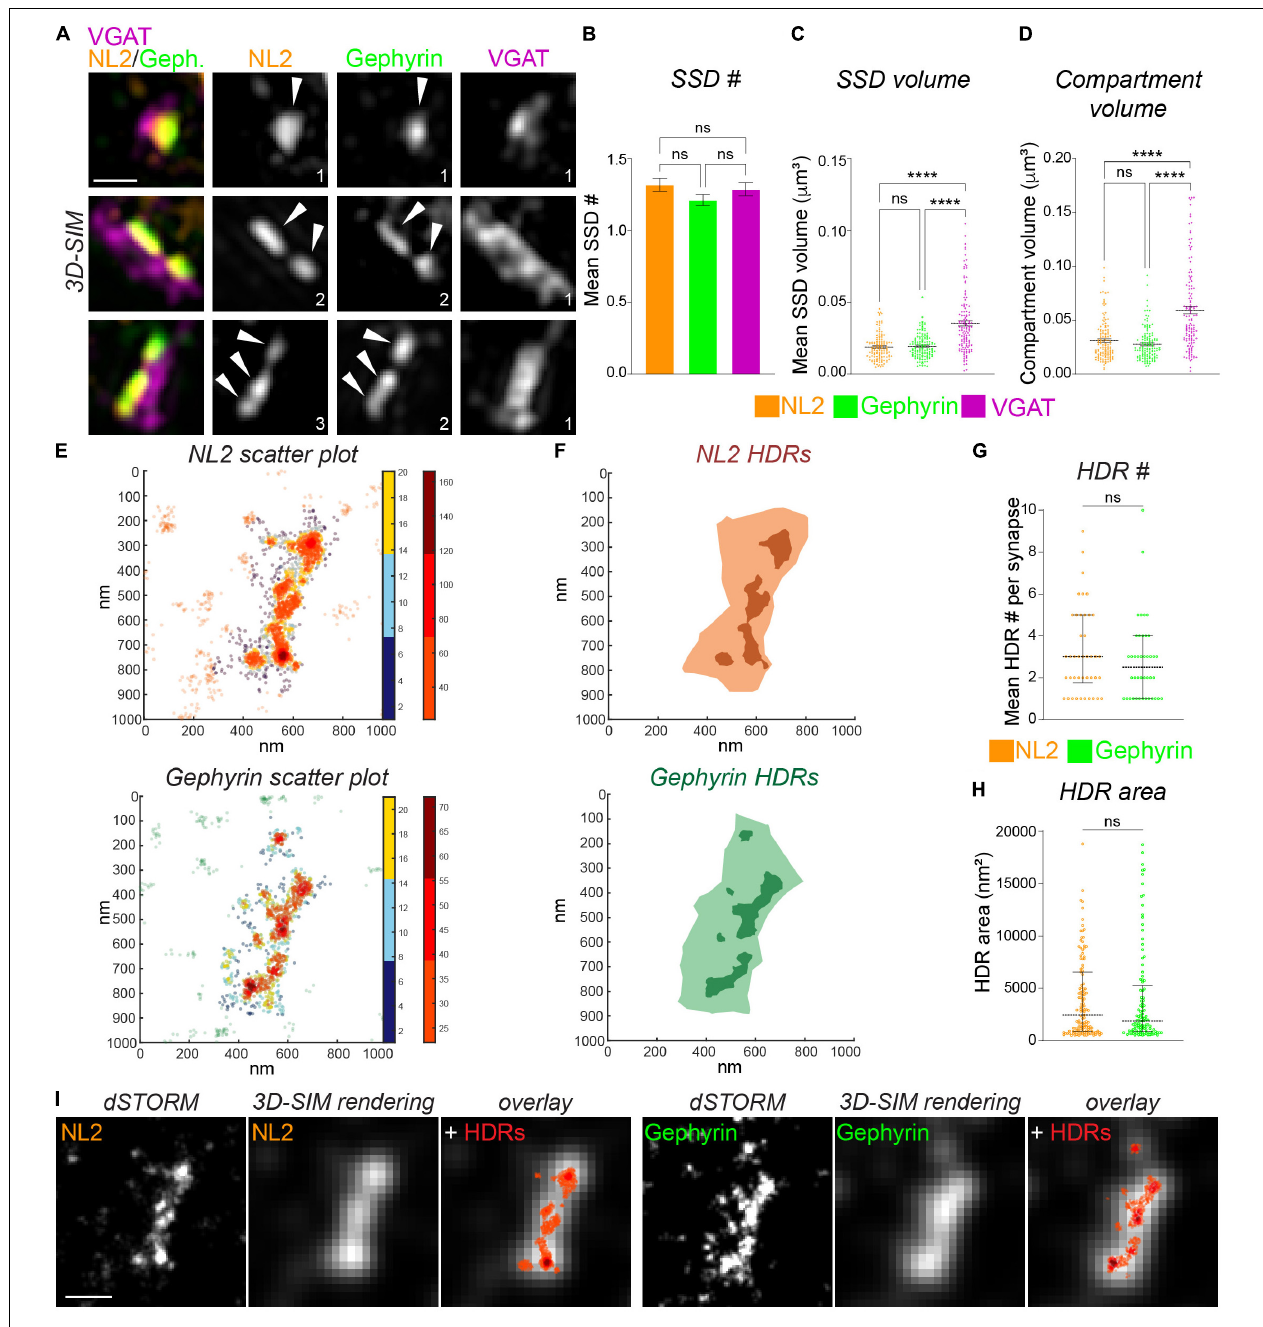
FIGURE 2 | Measurement of NL2 substructure parameters by 3D-SIM and d STORM. (A) Maximum projection 3D-SIM images of hippocampal inhibitory synapses labeled for NL2, gephyrin and VGAT. Numbers denote number of SSDs in compartment. (B) Mean number of SSDs per compartment. p = 0.186 (Kruskal–Wallis); n = 132 synapses. (C) Individual SSD volumes for NL2, gephyrin, and VGAT. **** p < 0.0001 (Kruskal–Wallis, Dunn’s post hoc ); n = 132 synapses. Horizontal line denotes mean. (D) Compartment volumes for NL2, gephyrin, and VGAT. **** p < 0.0001 (Kruskal–Wallis, Dunn’s post hoc ); n = 132 synapses. Horizontal line denotes mean. (E) Heat maps of NL2 and gephyrin localizations generated by d STORM. Hot colors (color-bar 2) represent localizations that are classified as high-density (HDRs), remaining synaptic localizations are shown in cooler colors (color-bar 1). (F) Diagrams showing the delineation of NL2 and Gephyrin HDRs (darker shades) and NL2 and gephyrin post-synaptic regions (lighter shades). (G) Number of HDRs per compartment for NL2 and gephyrin. Horizontal lines denote median and 25–75% quantiles. p = 0.333 (Mann Whitney), n = 42 synapses. (H) Individual NL2 and gephyrin HDR areas. Horizontal line denotes median and 25–75% quantiles. p = 0.518 (Mann Whitney), n = 42 synapses. (I) Images showing d STORM rendered image at d STORM and 3D-SIM resolution, with identified HDRs overlaid in red. Scale bar = 250 nm.